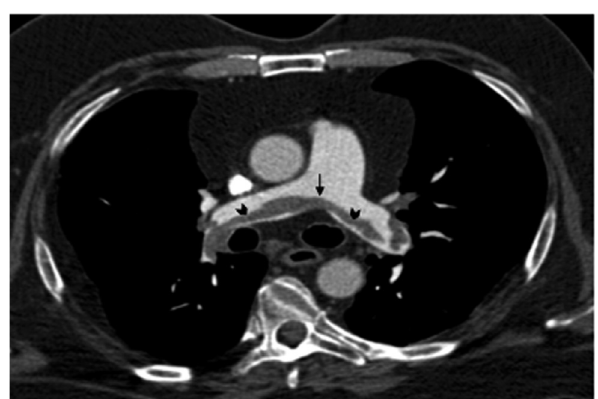
Fig. 1 Chest CT angiography depicting a saddle PE. Image shows thrombus straddling the bifurcation of the pulmonary artery trunk (arrow) with extension into both main pulmonary arteries (arrow- heads). CT, computed tomography; PE, pulmonary